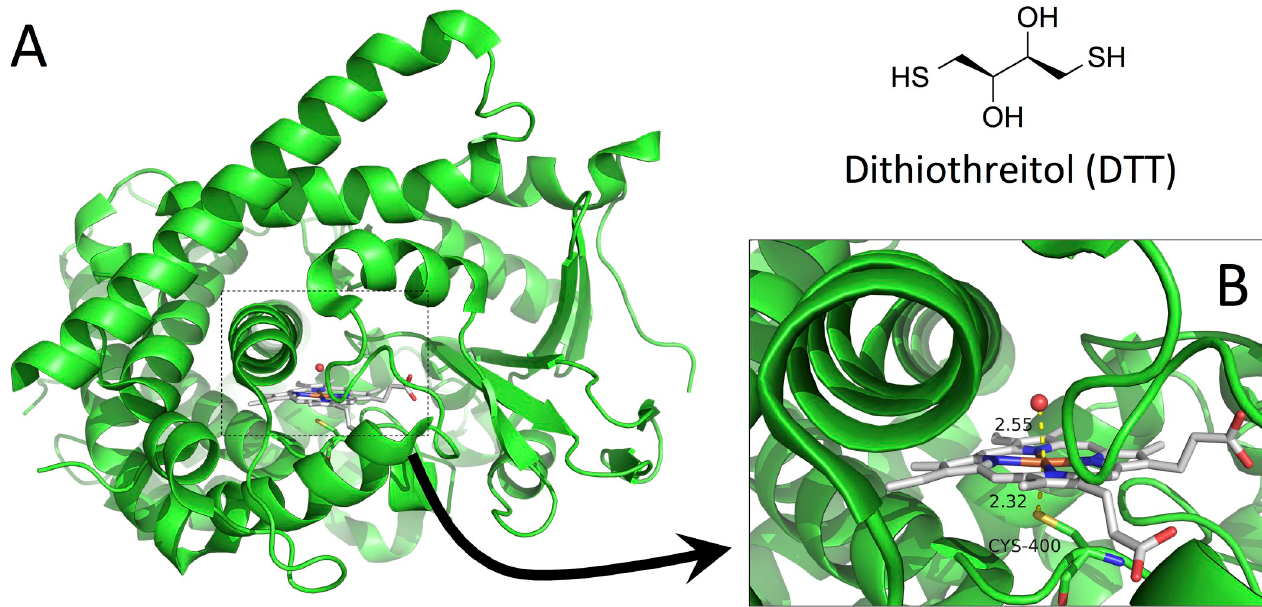
Fig 1. Structure of M11. (A) Three-dimensional structure of the heme domain of the CYP BM3 M11 mutant (without organic ligand in the active site; PDB entry 5E9Z) [16]. (B) Zoom-in on active site showing a water molecule and Cys400 adopting the axial positions at the hexa-coordinated Fe atom in the heme group. The 2D structure of DTT is also